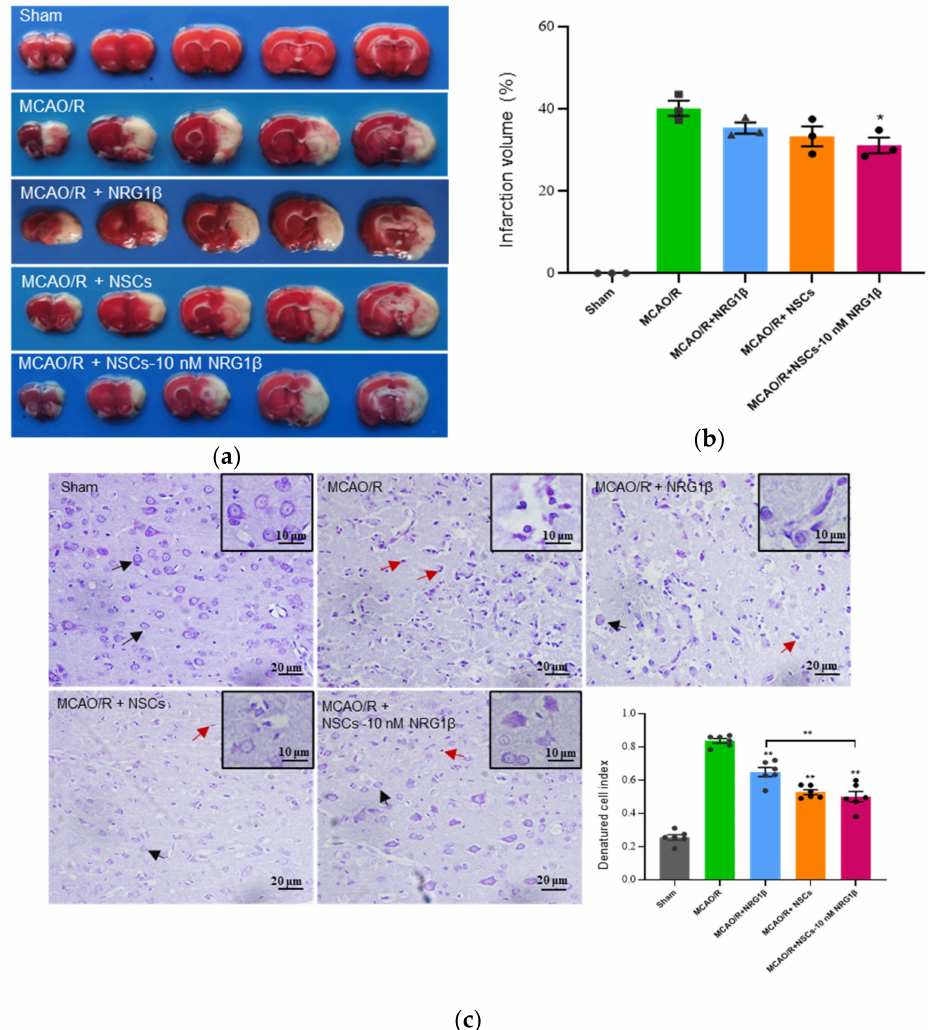
Figure 2. Effect of NSCs-10 nM NRG1 β transplantation on infarct volumes and damage of cortical neuron in rats. ( a ) Representative images of infarct volumes in different groups by TTC staining (The white color illustrates the infarct region and red-colored indicate the normal portion). ( b ) The percentage of infarct volume relative to the whole brain of different groups ( c ) Representative morphology of infarct neurons in different groups by Nissl staining. (The black arrow indicates normal cells and the red arrow indicates DCI). DCI in Sham, MCAO/R, MCAO/R + NRG1 β , MCAO/R + NSCs and MCAO/R + NSCs-10 nM NRG1 β group. Experiments were repeated at least three times, and at least 5 horizons were chosen each time. * p < 0.05, ** p <